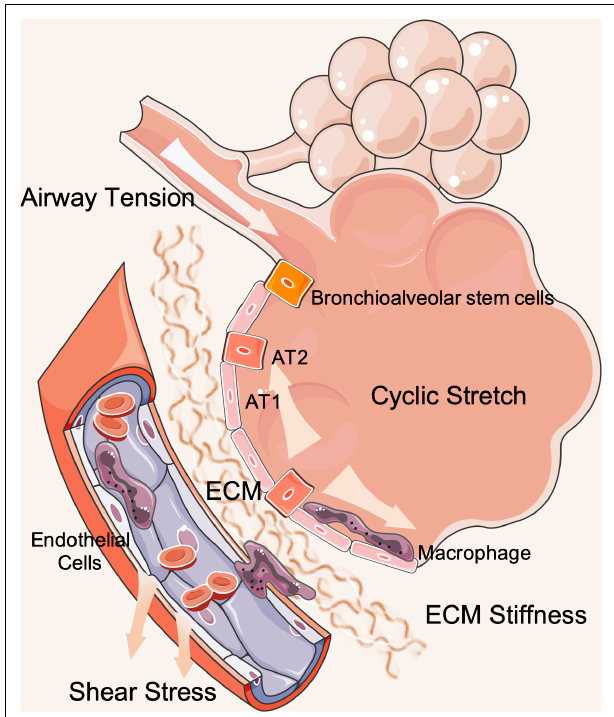
FIGURE 1 | The schematic diagram of mechanical stresses loading on pulmonary alveoli and blood vessels. AT1, alveolar type 1 cells; AT2, alveolar type 2 cells; ECM, extracellular